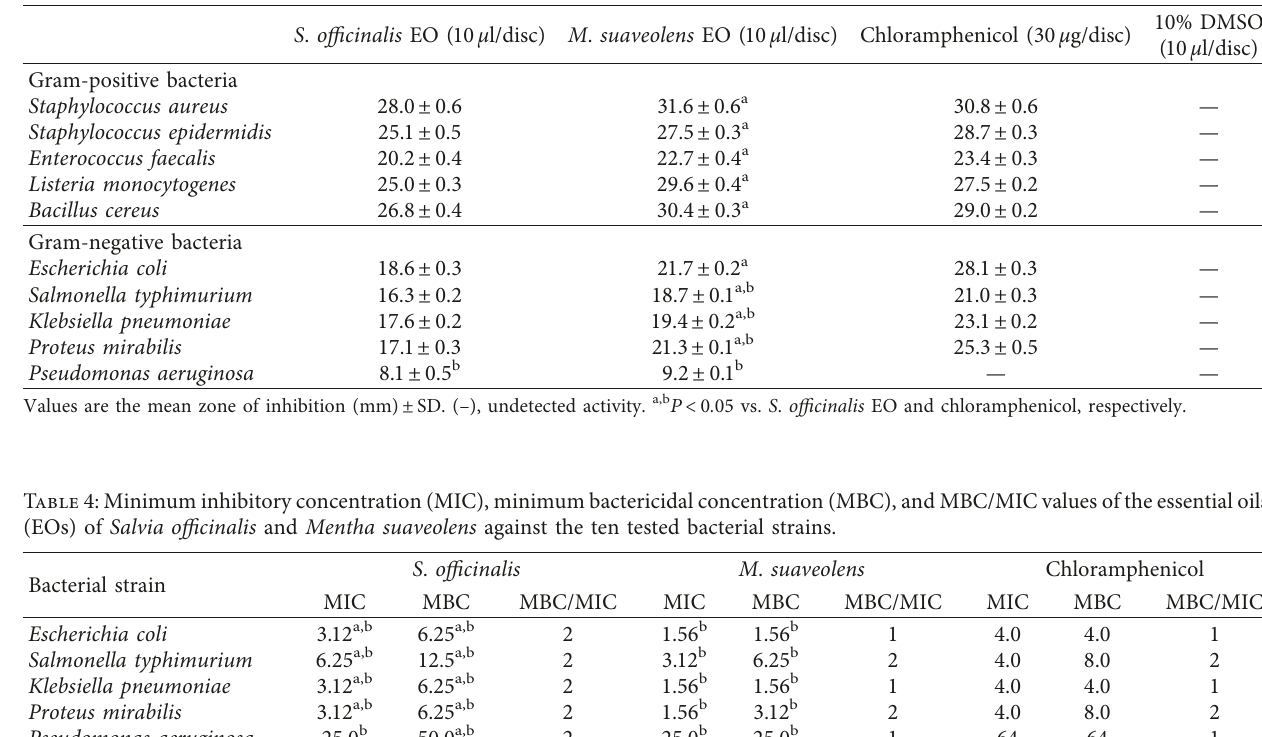
Klebsiella pneumoniae